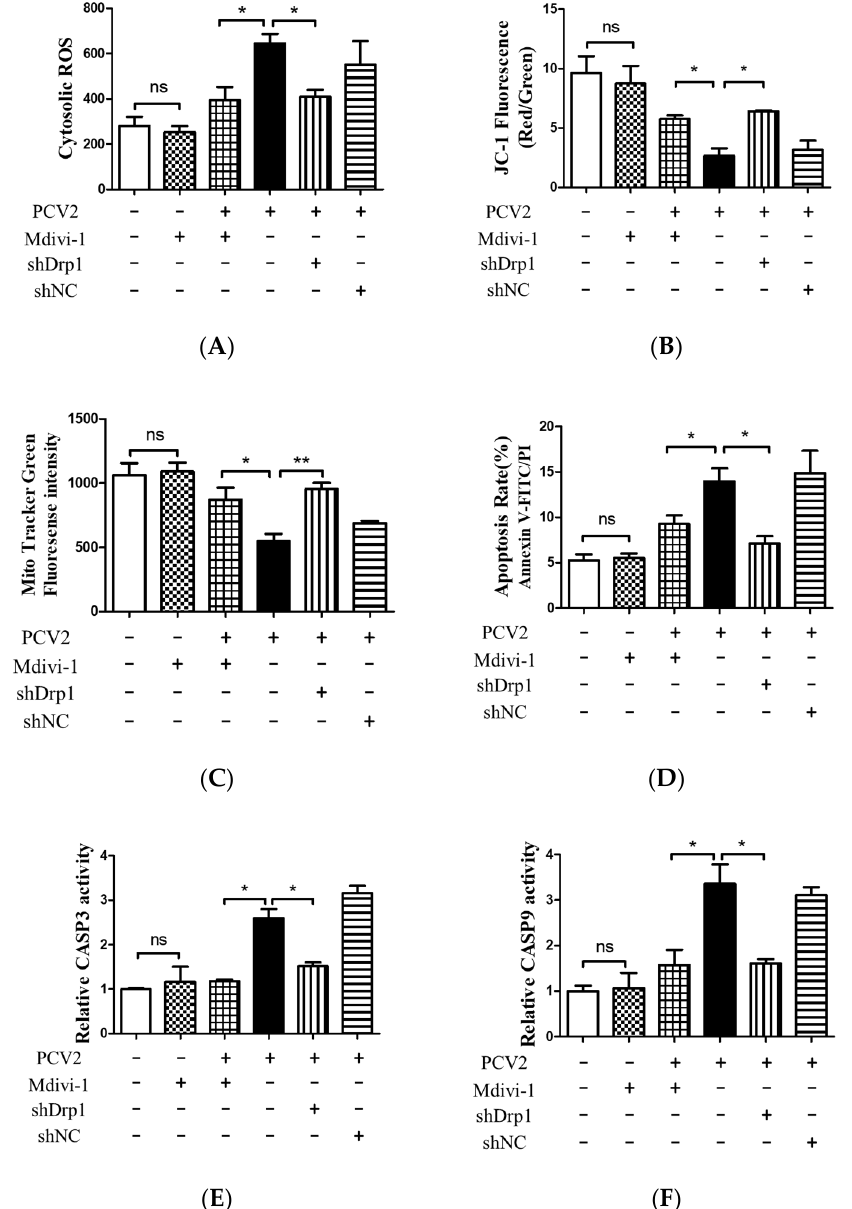
Figure 8. Inhibition of Drp1 by shDrp1 and Mdivi ‐ 1 decreased the cytosolic ROS, rescued mitochondrial mass and MMP, and reduced apoptosis due to the infection by PCV2. PK ‐ 15 cells in 24 ‐ well plates were first infected with the lentivirus containing specific shDrp1 (shDrp1) for 12 h and then infected with PCV2 for 48 h. Alternatively, PK ‐ 15 cells were infected with PCV2, treated with 4 μ M Mdivi ‐ 1 at 2 hpi, and then incubated for an additional 46 h. ( A ) Cytosolic ROS in the cells were evaluated using flow cytometry, shown as the mean value of the DCF fluorescence intensity. ( B ) JC ‐ 1 fluorescence was depicted as the ratio between red and green fluorescent signals to indicate changes in the mitochondrial membrane potential. ( C ) Mitochondrial mass was measured with MitoTracker green staining using flow cytometry. ( D ) Apoptosis rates of PK ‐ 15 cells examined using flow cytometry. ( E , F ) The bar charts show fold changes of caspase 3 ( E ) and caspase 9 ( F ) enzyme activities in the cells. Bar charts ( A , C , E , F ) show the mean ± SEM of three independent experiments. * p < 0.05 and ** p < 0.01.